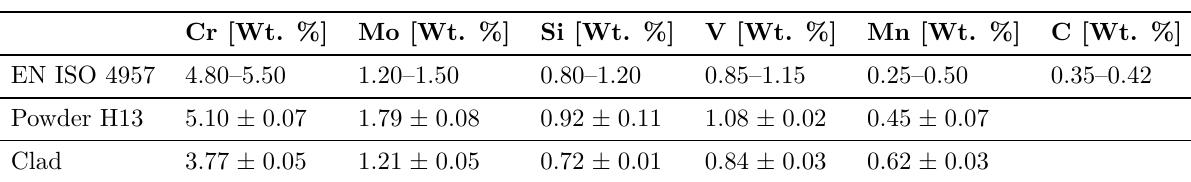
Table 1. Chemical composition of the steel AISI H13 according to ISO 4957 [6], the powder and the clad.